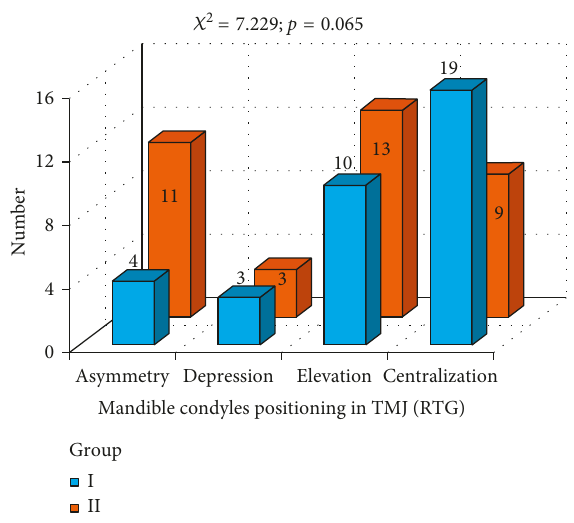
Figure 12: Evaluation of condyles centralization in group I and group II.